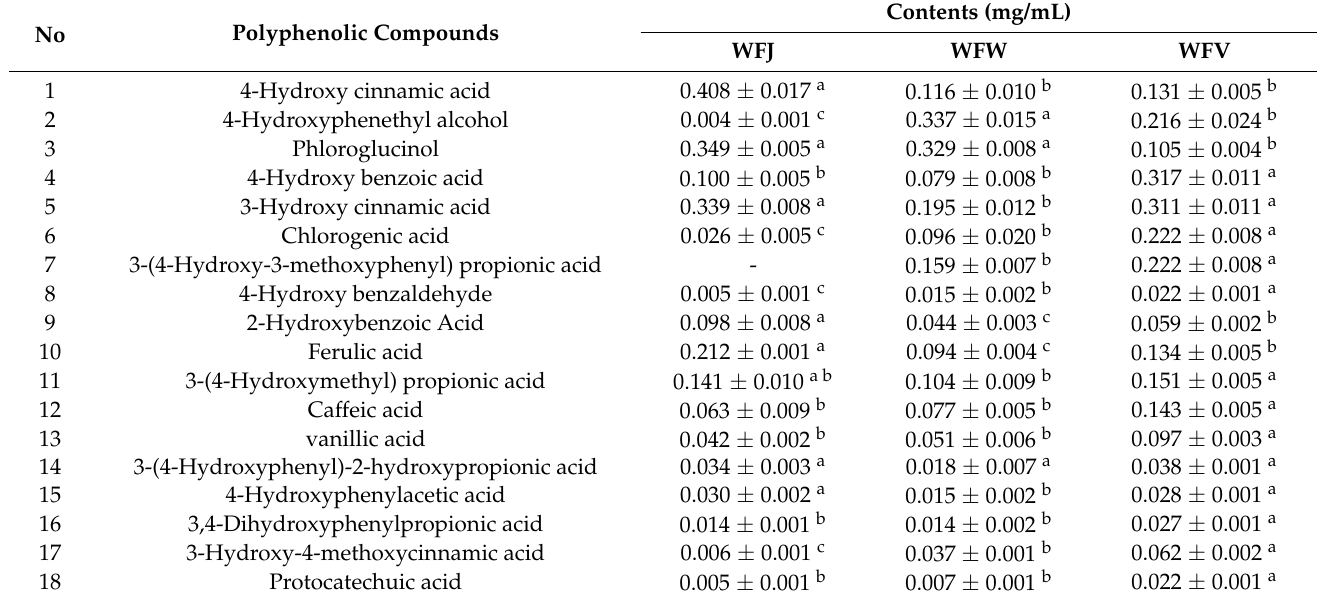
Table 5. Types and contents of polyphenols in wolfberry fruit vinegar in the fermentation